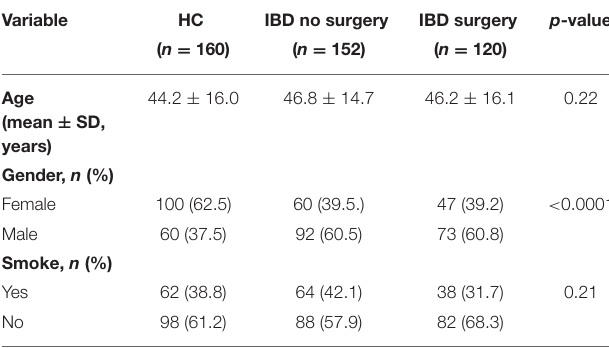
TABLE 1 | Baseline variables of the two cohorts of patients with IBD and of the healthy controls (HC) included in the study.